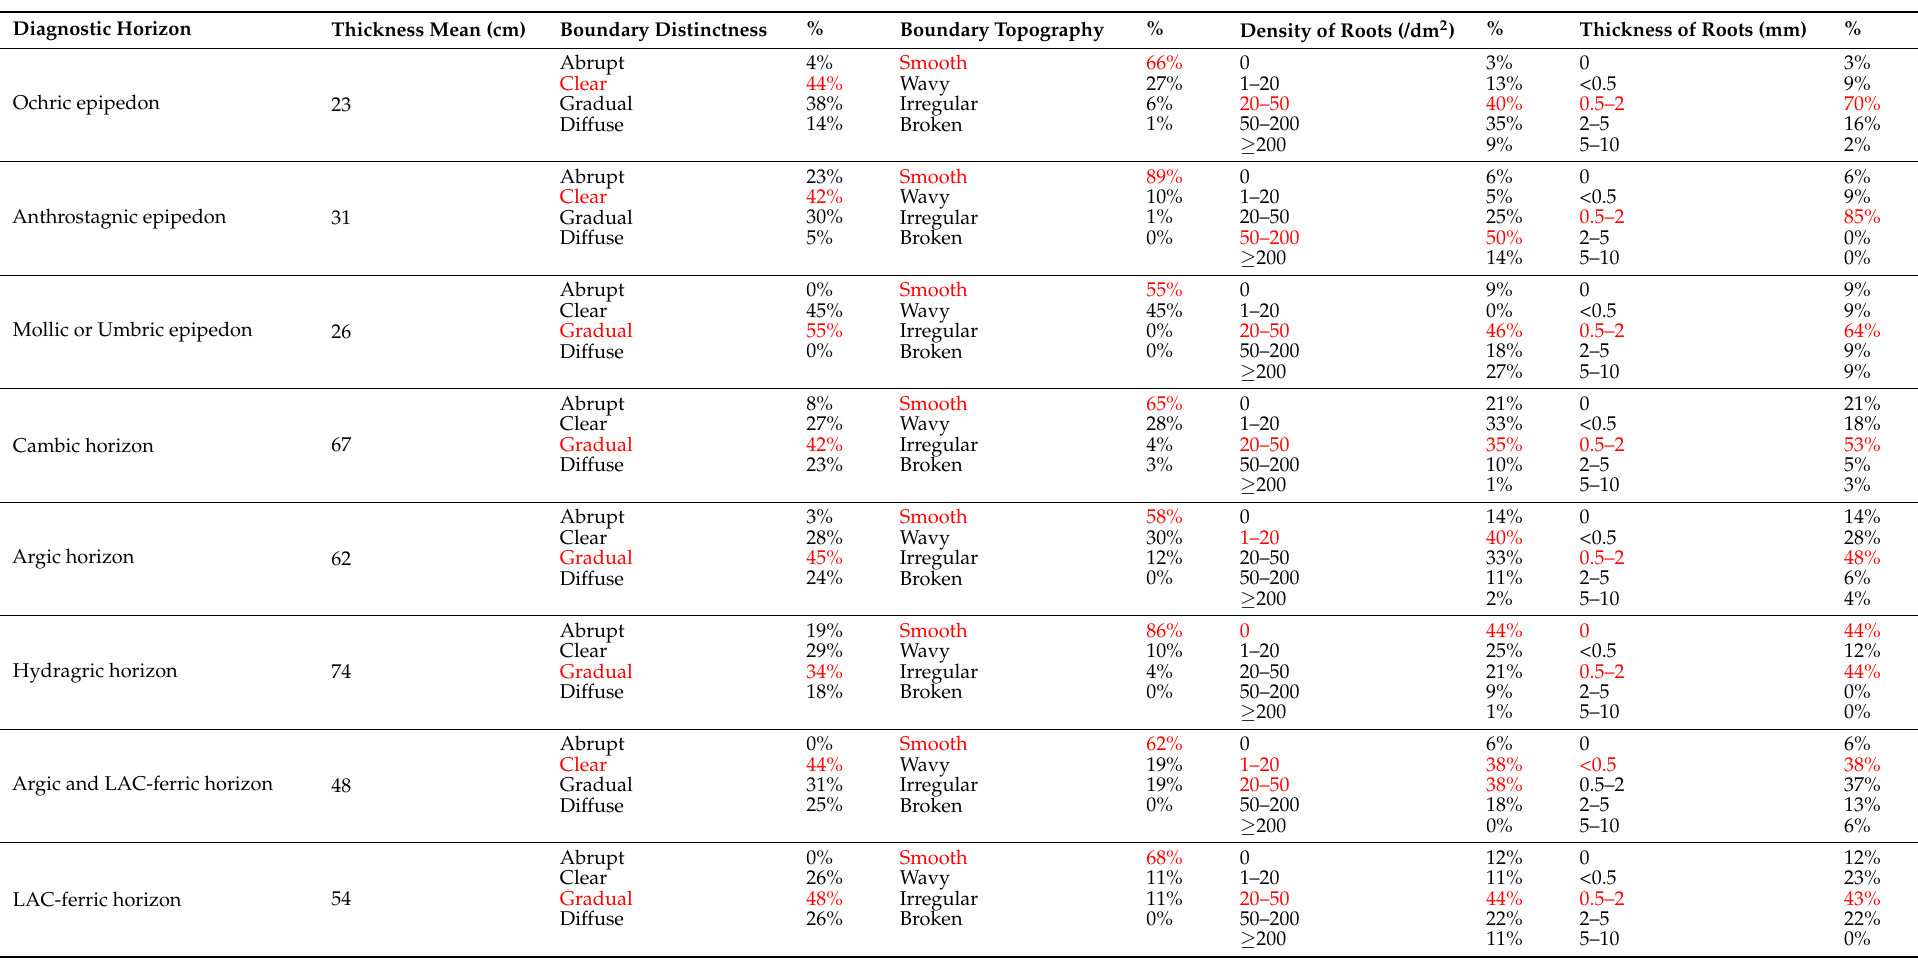
Table 2. The thickness, boundary, and root description of each diagnostic horizon. Boundary distinctness represents the thickness of the intersection region between a horizon and the one below it (abrupt: <2 cm, clear: 2–5 cm, gradual: 5–12 cm, and diffuse: ≥ 12 cm). Boundary topography was divided in the same way as in US Soil Taxonomy (ST). The highest percentage of each category is marked in